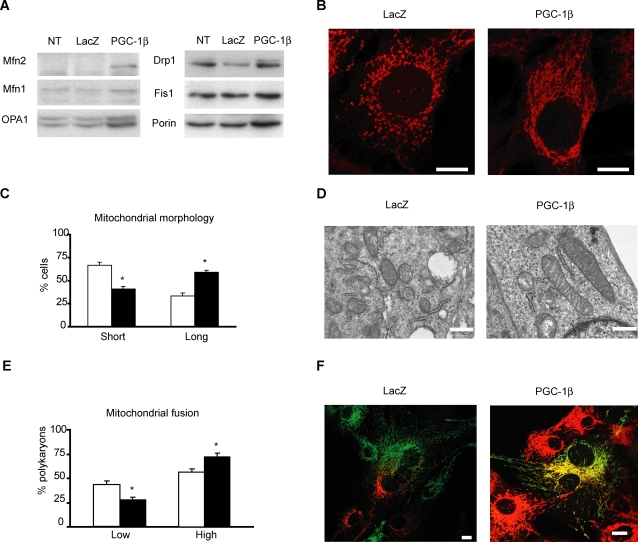
PGC-1β increases the rate of mitochondrial fusion and changes mitochondrial morphology.(A) Representative Western blot of three independent experiments of C2C12 myoblasts transduced with LacZ or PGC-1β adenovirus at a MOI 200 during 48 h. 40 µg of protein from lysates were loaded and Mfn2, Mfn1, Opa1, Drp1, Fis1 and Porin were detected with specific antibodies. (B) Representative images from a duplicate of one of the same three independent transduction experiments performed in panel (A). Mitochondria were labelled with anti-Cox1 antibody detected with a secondary antibody conjugated to Alexa 594. Scale bar, 10 µm. (C) C2C12 myoblasts quantification and classification attending to mitochondrial tubule length (150–200 cells counted per transduction). Myoblasts with a mean mitochondrial tubule length <4 µm were considered “Short” and >4 µm were considered “Long”. Results are mean±SEM and expressed as percentage of total C2C12 myoblasts counted from three independent transduction experiments with LacZ (white bars) or PGC-1β (black bars) at MOI of 200. *, statistical difference at p<0.01. (D) Electron microscopy images of C2C12 myoblasts transduced with LacZ or PGC-1β adenovirus as in panel (A) were taken at 40.000x magnification . Scale bar 500 nm. (E) 4 hours after PEG, polykaryons of C2C12 myoblasts transduced as in (A) were counted attending to mtGFP (mitochondrial matrix- targeted green fluorescent protein) and mtRFP (mitochondrial matrix-targeted red fluorescent protein) mixing (detected as yellow mitochondria). Polykaryons classified as “Low” displayed <50% of mixed mtGFP and mtRFP (yellow mitochondria). Polykaryons classified as “High” displayed ≥50% of yellow mitochondria. Graphs show mean±SEM of percentage of total polykaryons counted from three independent cell fusion experiments and transduction experiments with LacZ (white bars) or PGC-1β (black bars) at MOI of 200. *, statistical difference at p = 0.02. (F) Representative images from one of three independent transduction and polyethylene glycol-mediated (PEG) cell fusion experiments. C2C12 myoblasts stably expressing mitochondrial matrix-targeted green fluorescent protein (mtGFP) or red fluorescent protein (mtRFP) were transduced with LacZ or PGC-1β adenovirus as in panel (A). Polykaryons were fixed 4 h after 30”–40” PEG treatment. During these 4 h, cells were incubated in growth medium with 100 µg/ml of cycloheximide to inhibit de novo synthesis of mtGFP and mtRFP. Degree of fusion is directly proportional to mixing of mtGFP and mtRFP (yellow mitochondria). Scale bar, 10 µm.